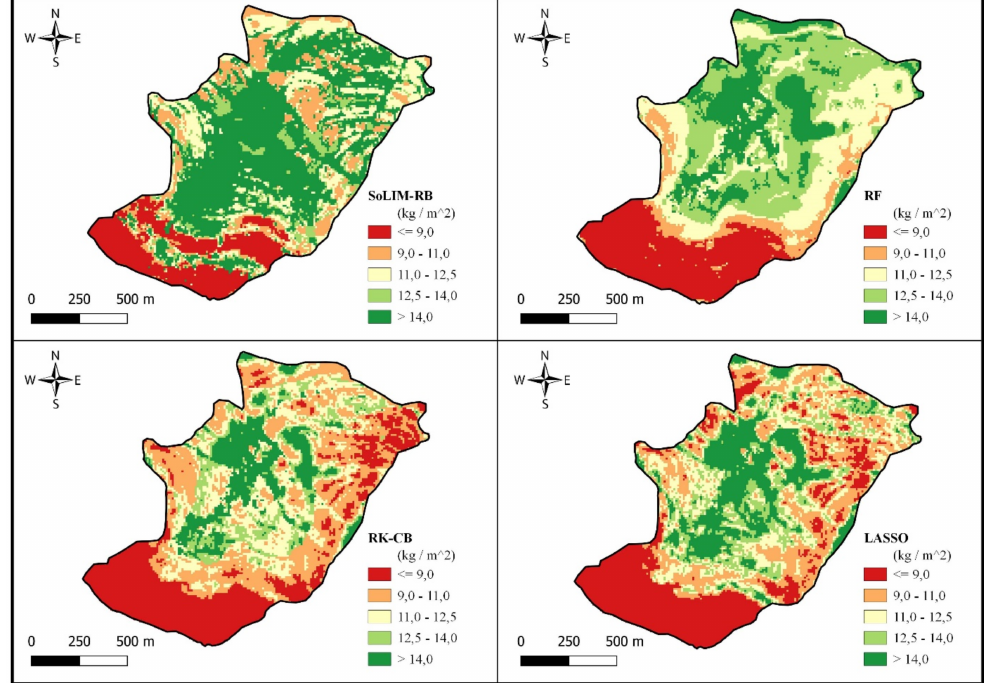
Figure 8. A comparison between the Vemvane catchment’s SoLIM-RB, RF, RK-CB, and LASSO, in order of their performance in regard to error